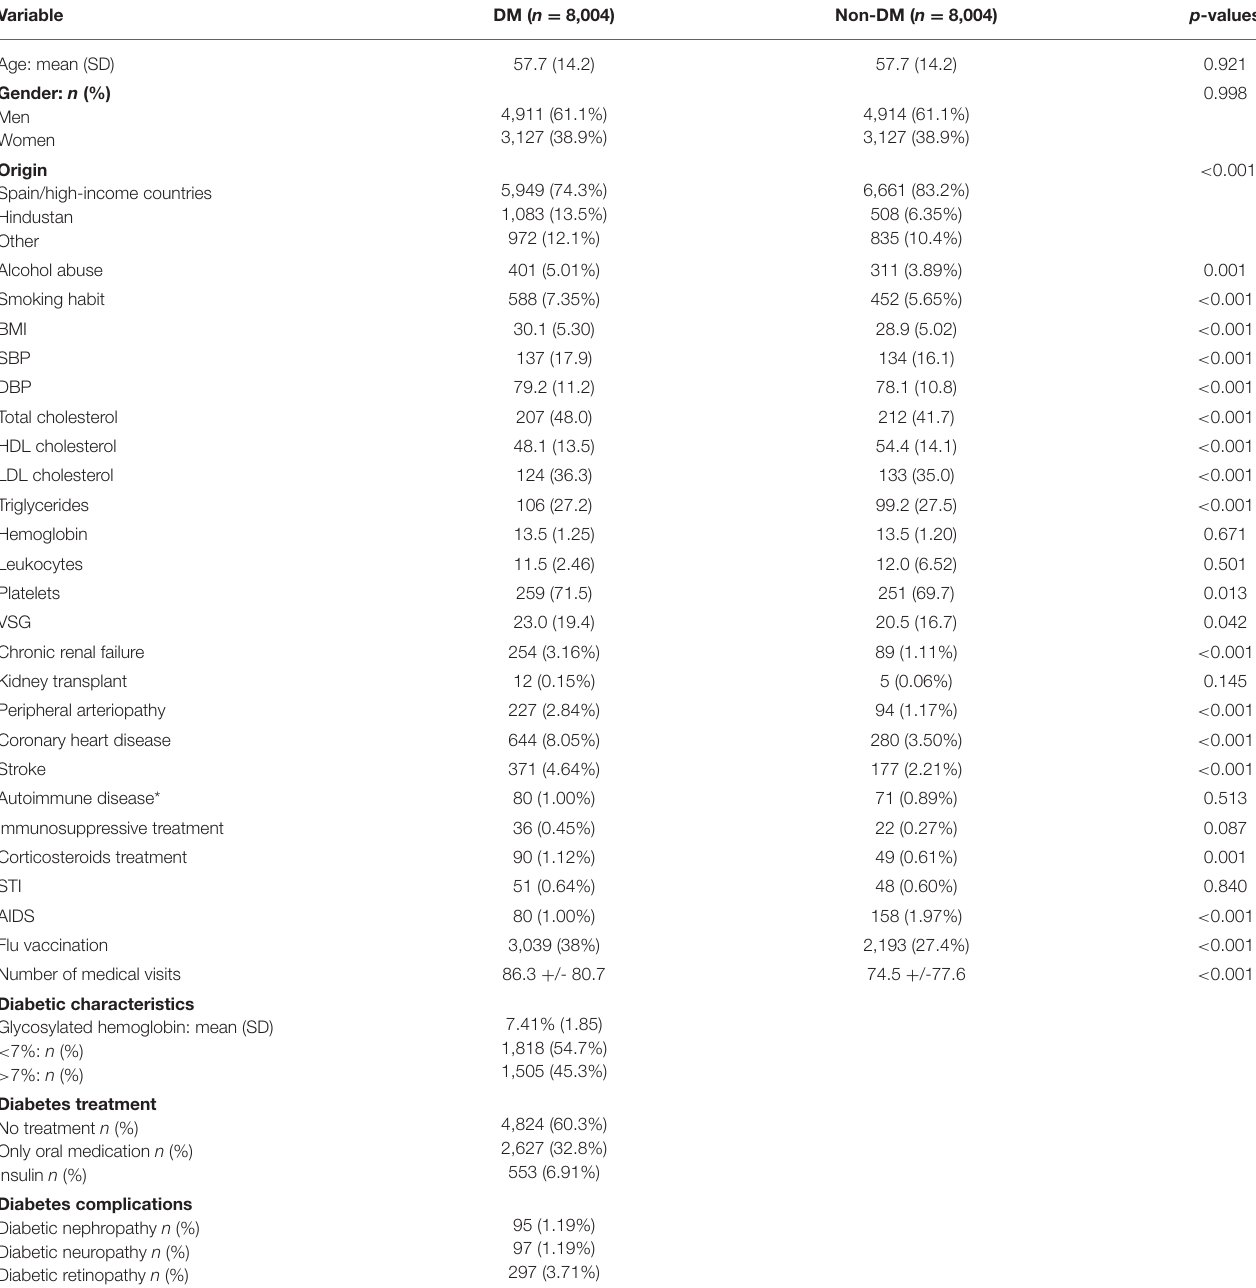
TABLE 1 | Baseline characteristics of the study variables between diabetic and non-diabetic cohorts.